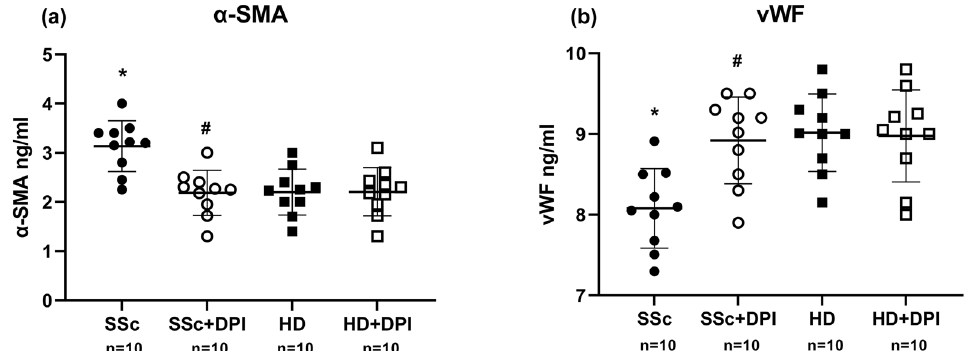
Figure 4: E ff ects of SSc sera on EndMT markers expression in HPMECs ( a ) SSc sera induce α - SMA expression in HPMECs. ( b ) SSc sera inhibits vWF expression in HPMECs. ( a and b ) Subcon fl uent HPMECs were cultured for 48 h in basal medium containing 10% ( v/v ) of sera from SSc patients ( SSc ) and healthy donor ( HD ) . Cells were then processed for the determination of both α - SMA and vWF as reported in the material methods. In selected experiments, HPMECs were preincubated for 1 h with 5 µM of the NADPH oxidase inhibitor DPI before sera stimulation. ( a and b ) Data are expressed as nanogram per milliliter of protein. Horizontal lines indicate the mean value and standard deviation range. Kruskall – Wallis one - way analysis of variance, followed by a post hoc Dunn ’ s test for multiple comparisons, was used to detect di ff erences among studied groups. ( a ) * p ≤ 0.006, signi fi cantly di ff erent from the control group ( HD ) ; # p ≤ 0.008, signi fi cantly di ff erent from the SSc group ( SSc ) . ( b ) * p ≤ 0.01, signi fi cantly di ff erent from the control group ( HD ) ; # p ≤ 0.02, signi fi cantly di ff erent from the SSc group ( SSc )